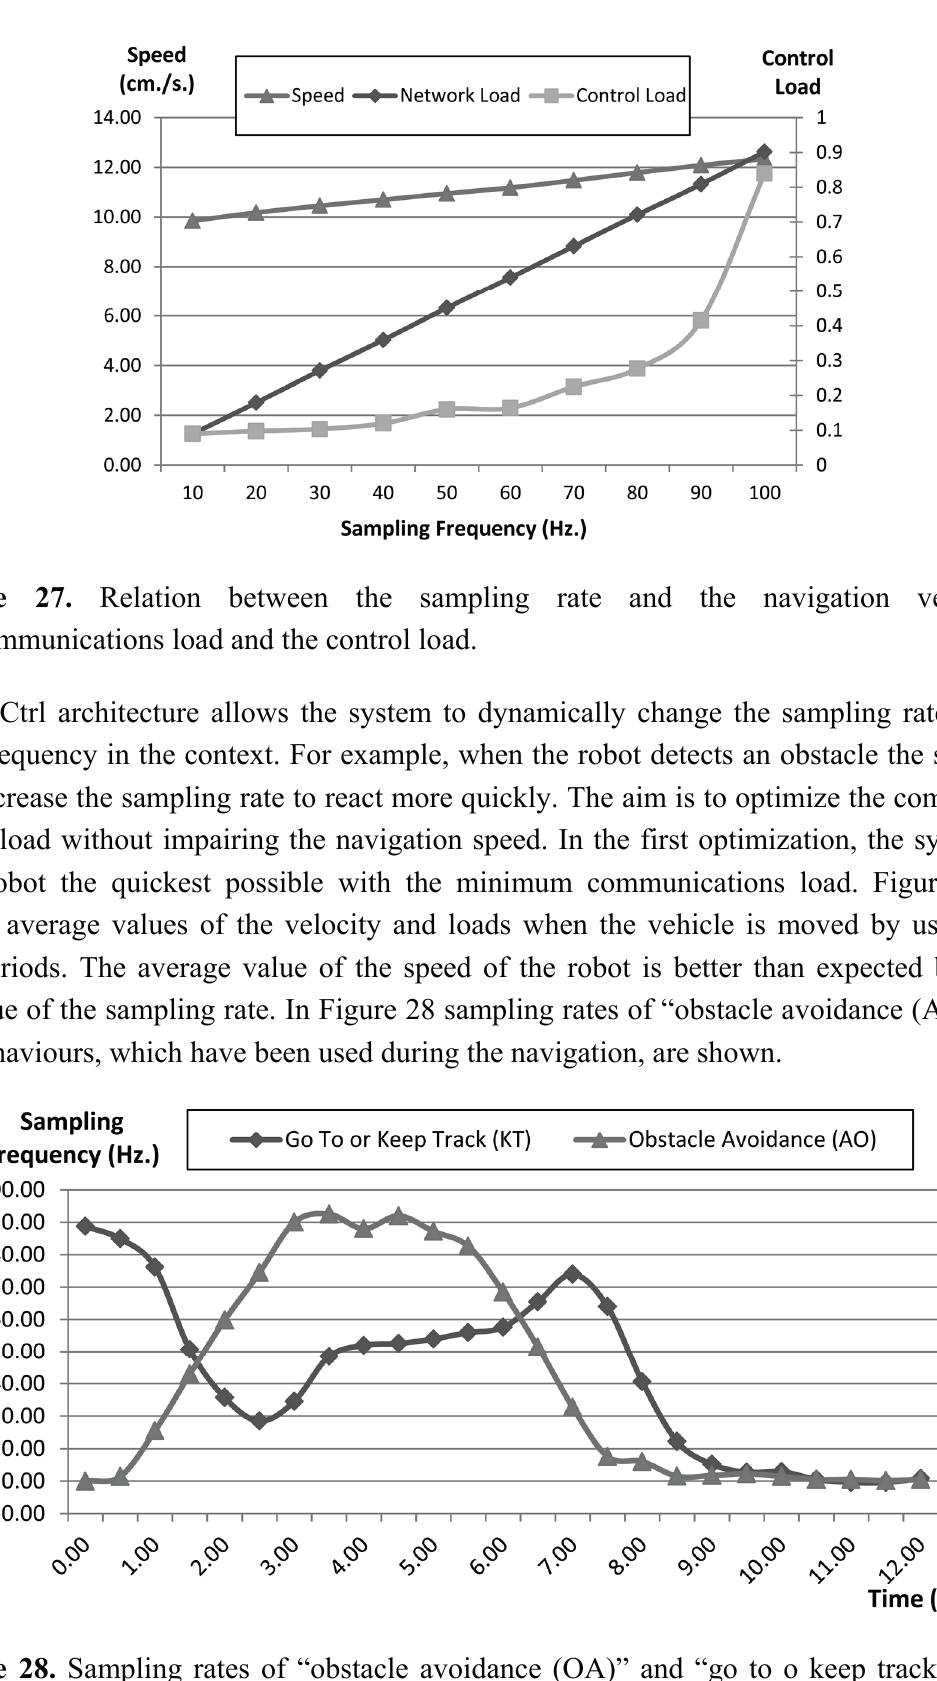
Figure 28. Sampling rates of “obstacle avoidance (OA)” and “go to o keep track (KT)” behaviours during navigation without optimization (Path